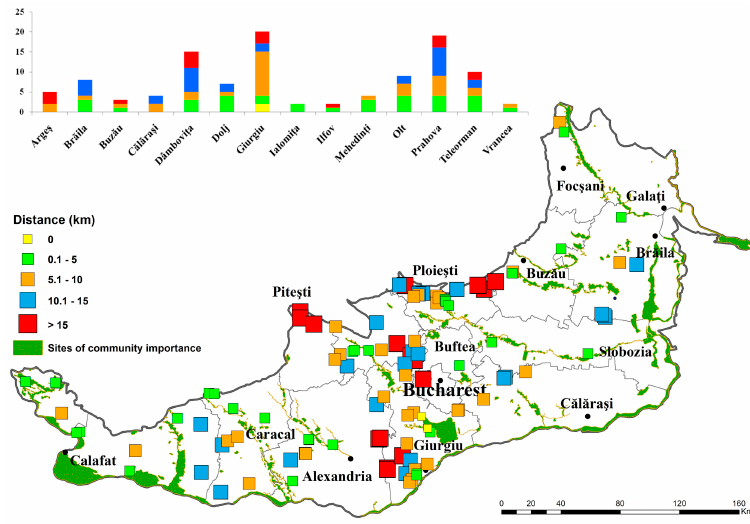
Figure 8. Distance of PV farms to SCIs.